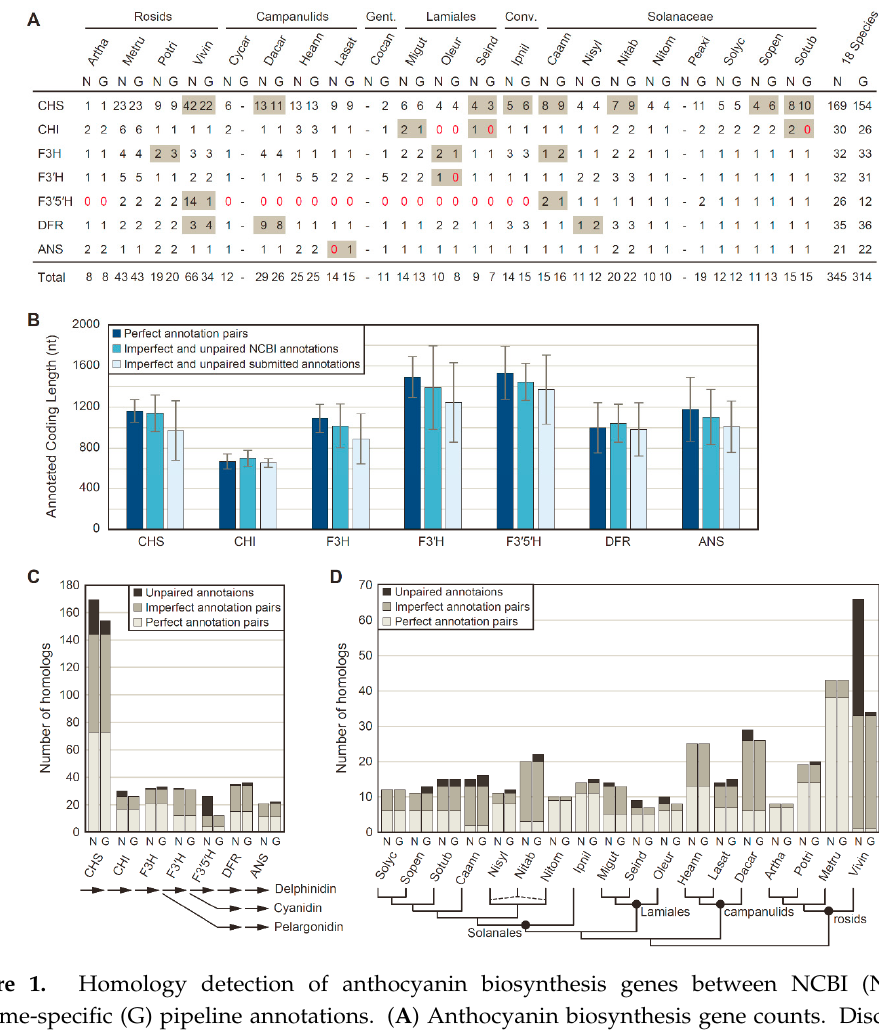
Figure 1. Homology detection of anthocyanin biosynthesis genes between NCBI (N) and genome-specific (G) pipeline annotations. ( A ) Anthocyanin biosynthesis gene counts. Discrepant values between annotation sources are shaded in gray. Zero values are denoted with red text. The sum totals at right include only the 18 species with NCBI and genome-specific pipeline annotations. Conv., Convolvulaceae; Gent., Gentianales. ( B ) Mean ± SD for coding sequence lengths in nucleotides (nt) of anthocyanin biosynthesis genes. ( C ) Number of homologs identified for each anthocyanin biosynthesis gene. A simplified anthocyanin biosynthesis pathway is shown at the bottom. ( D ) Number of homologs identified for each species. Phylogenetic relationships among sampled taxa is provided at the bottom. The dashed lines for N. tabacum (Nitab) indicates its allopolyploid nature, with S genome and T genome contributions from N. sylvestris (Nisyl) and N. tomentosum (Nitom),